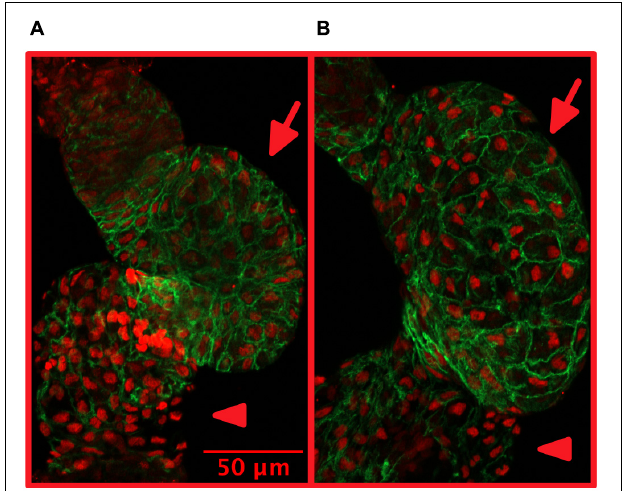
FIGURE 2 | Treatment with isoproterenol increases cardiomyocyte size. 4 dpf zebrafish without (A) and with (B) 300 µ M isoproterenol-treatment 2–4 dpf. Staining with Mef-2 antibody (red) to identify cardiomyocyte nuclei and with ZN-5 antibody (green) to delineate cardiomyocyte cell borders. Ventricles marked with arrows and atria marked with arrowheads. Adapted with permission from Paavola et al.